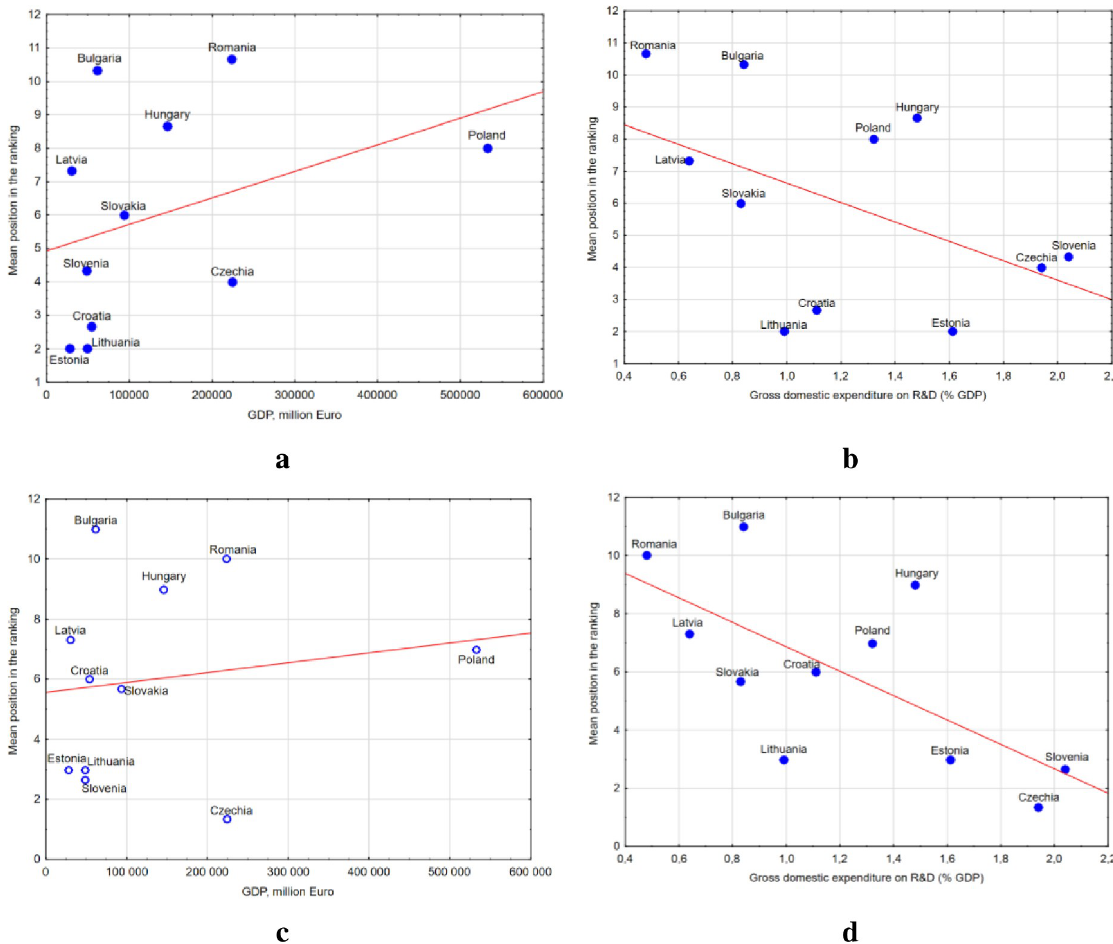
Fig 12. Ratio of GDP value and % GDP spent on R&D vs ranking position in terms of digital maturity (a-GDP value vs ranking position for all enterprises; b-% GDP spent on R&D vs ranking position for all enterprises; c- GDP value versus ranking position for manufacturing enterprises; d-% GDP spent on R&D vs ranking position for manufacturing